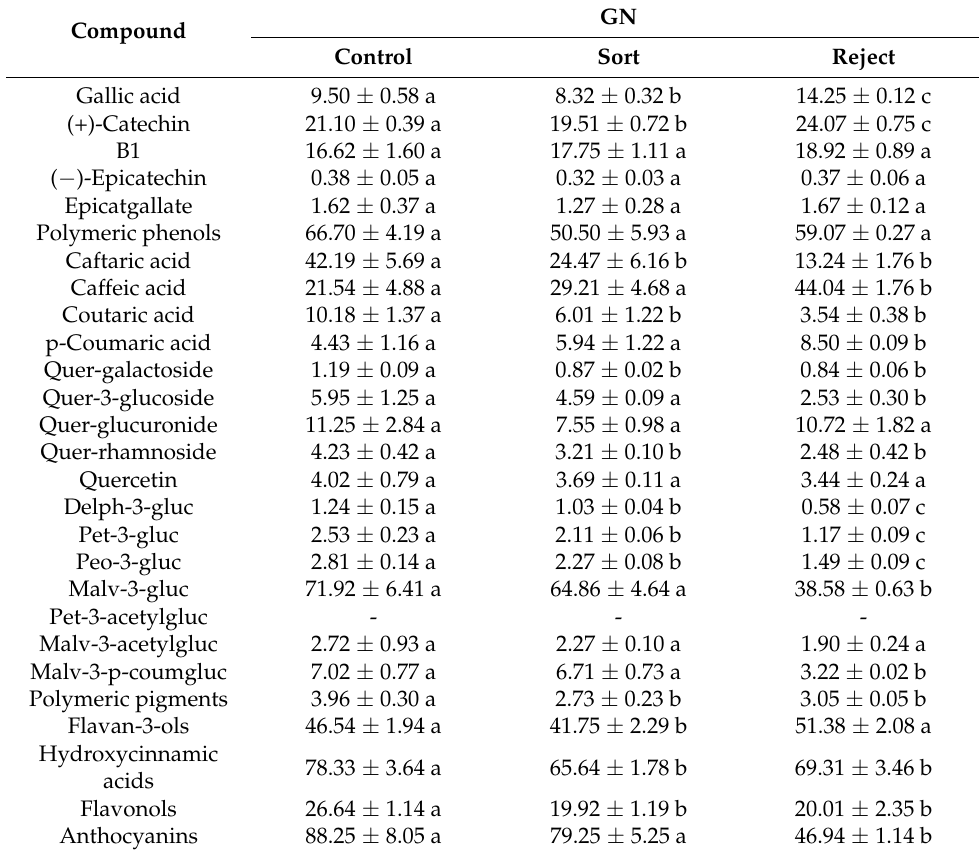
Table 7. Concentration (mg/L) of phenolic compounds in Grenache wines determined by reverse- phase high-performance liquid chromatography (RP-HPLC) from samples taken around six months after bottling.